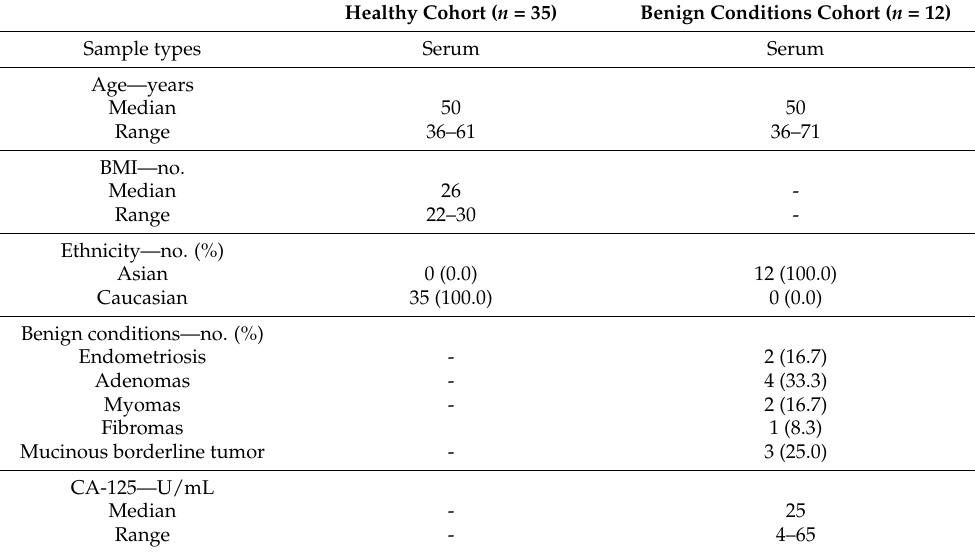
Table 5. Summary of characteristics across healthy and benign cohorts. This includes sample number, age, BMI, ethnicity, benign conditions and CA-125 level. Adenomas include seromucinous adenomas, serous cystadenomas and mucinous cystadenomas. Myomas include lipoleiomyomas and leiomyomas. Fibromas include serous